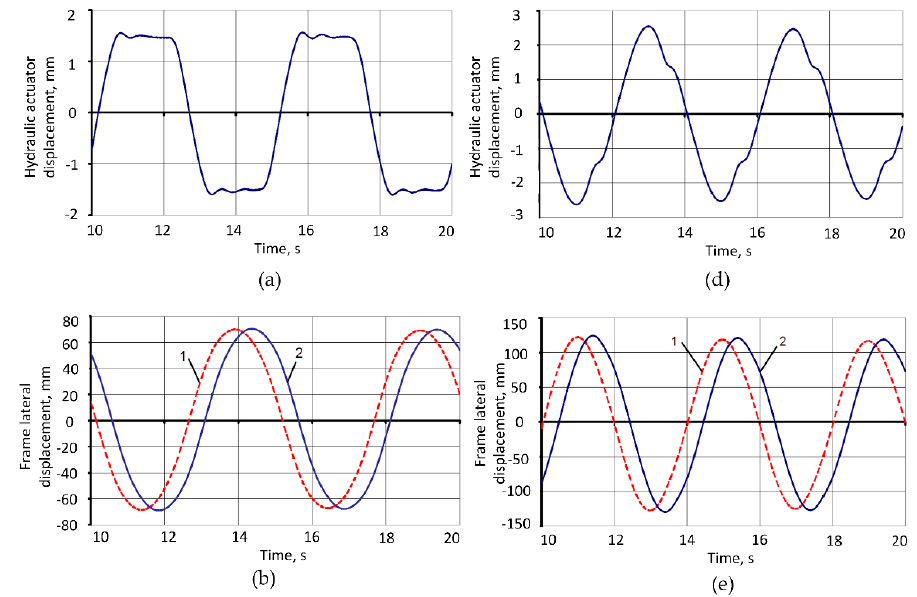
Figure 11. Example of simulation for anticipative driver siting before front axle of vehicle—( a ) hydraulic actuator displacement, ( b ) lateral displacement of front—1 and rear—2 axle, ( c ) yaw angular driver deviation, ( d ) hydraulic actuator displacement, ( e ) lateral displacement of front—1 and rear—2 axle, and ( f ) yaw angular driver